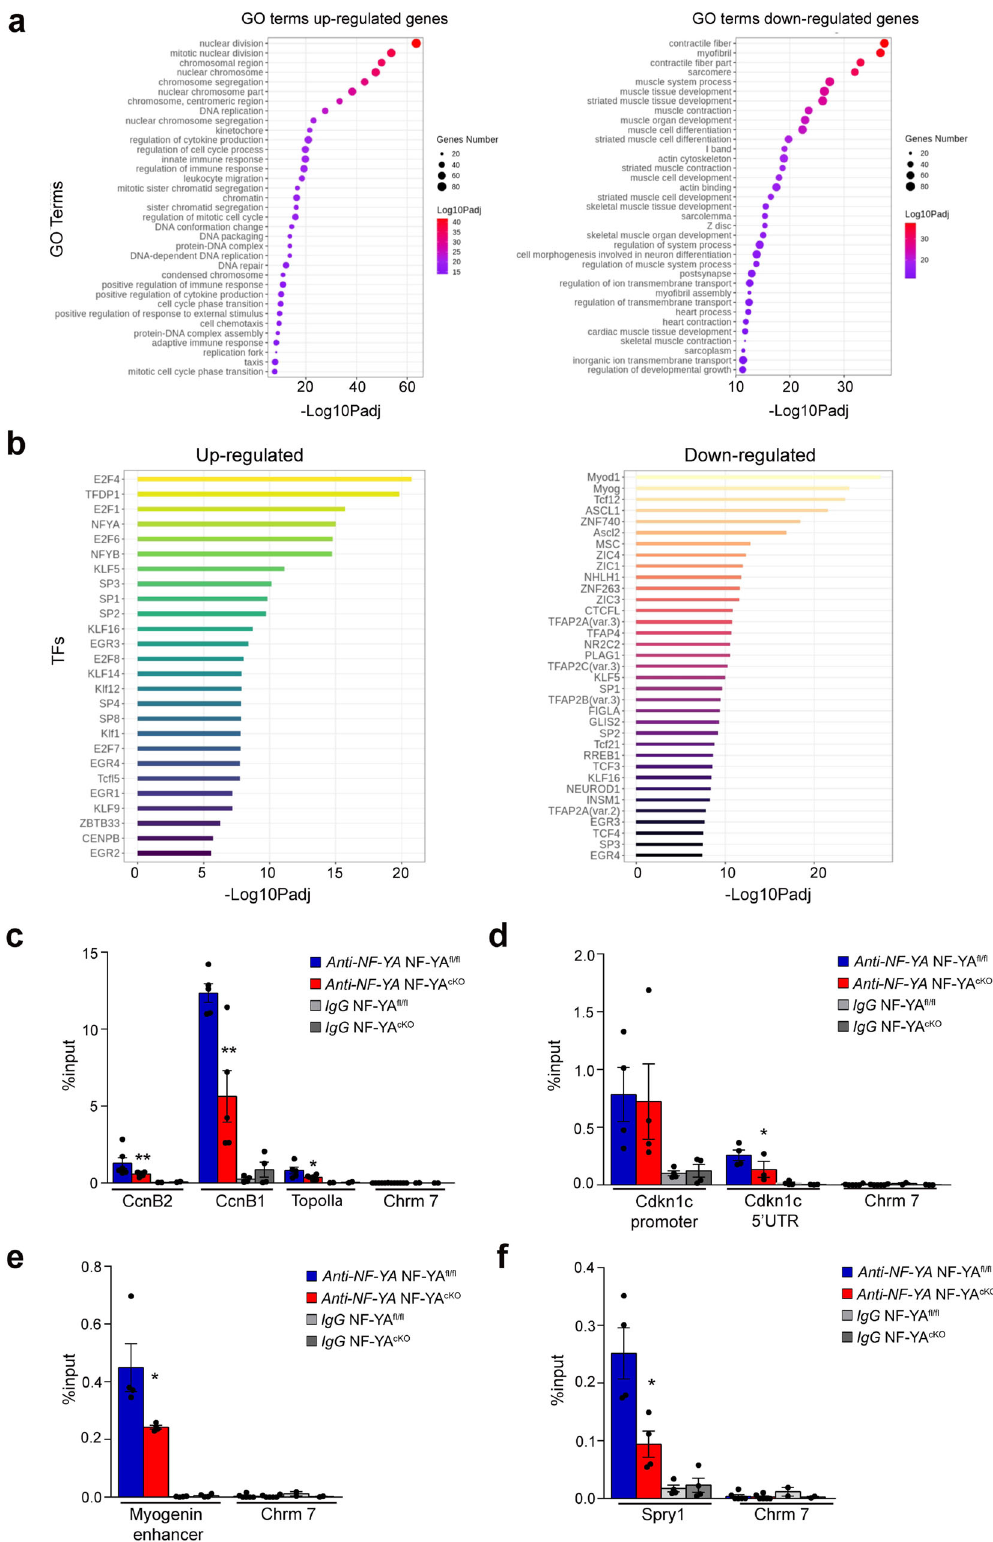
Overall, we provide evidence that NF-YA expression, and hence NF-Y activity, guarantees the survival of muscle stem cells and their ef fi cient progression from a committed to a fully dif- ferentiated state (Fig. 8). Our fi ndings highlight how a well- known cell cycle transcriptional regulator can be repurposed